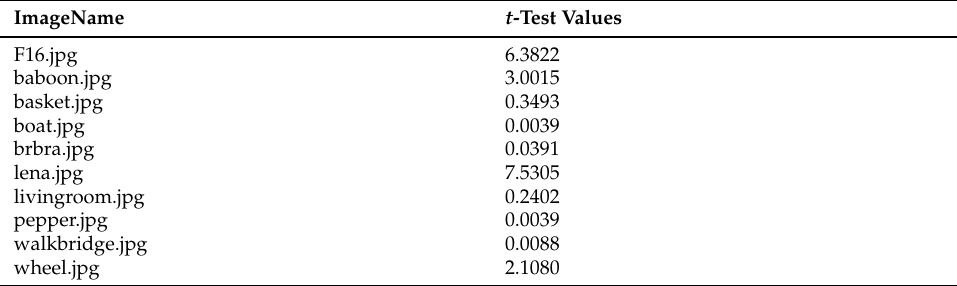
Table 4. t -Test values of proposed